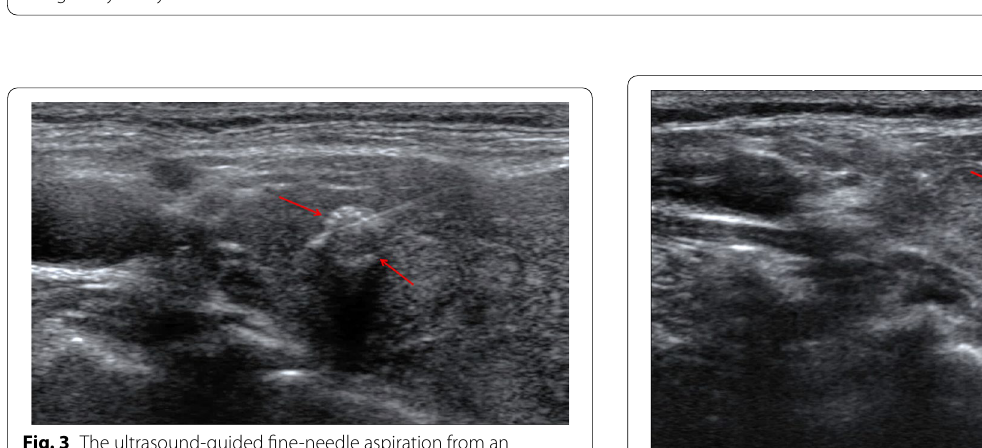
Fig. 2 Receiver operating characteristic (ROC) curve of different ultrasound classification systems (category 5; category 4 or 5) for predicting malignancy of thyroid nodules smaller than 10 mm